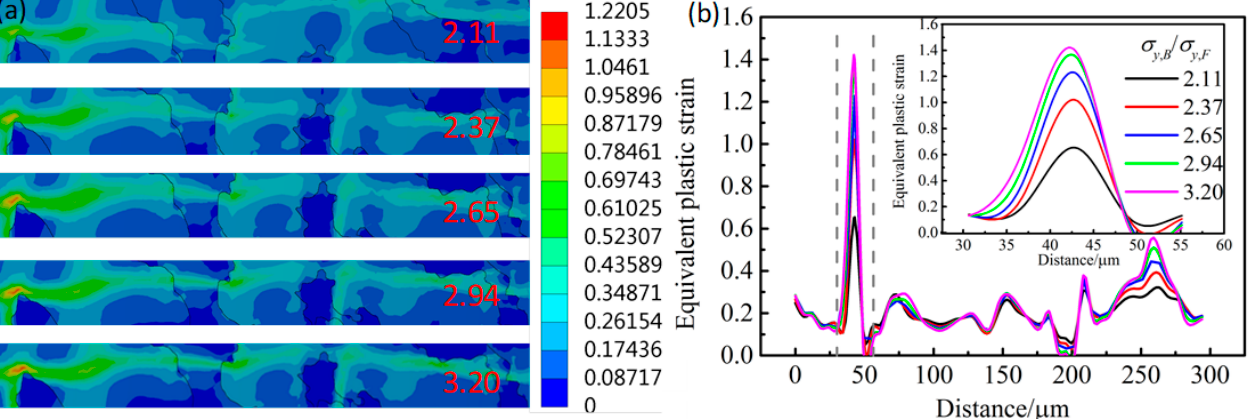
Figure 8. ( a ) Distribution of in-strain bands in Figure 5 and ( b ) line distribution of equivalent stain along the strain bands in models with different σ y , B / σ y , F